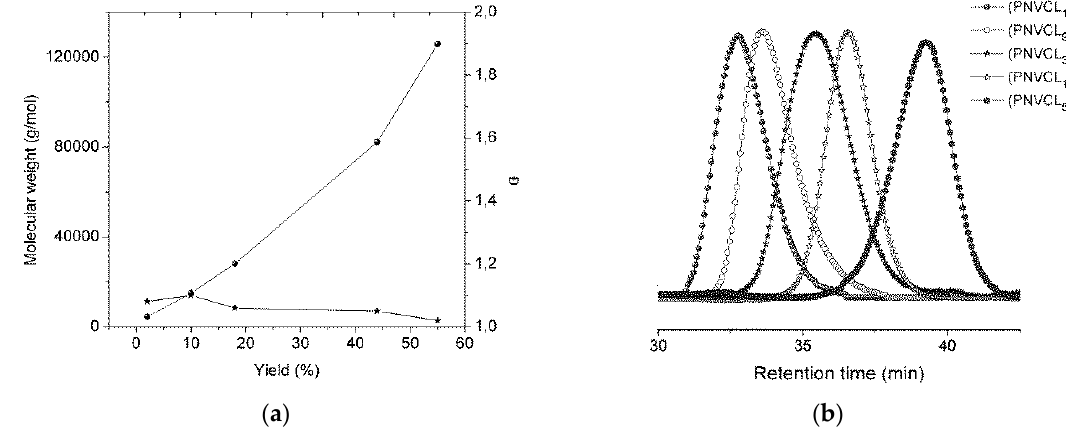
Figure 1. ( a ) Evolution of the molecular weight with conversion for the reversible addition–fragmentation chain transfer (RAFT) solution polymerization of PNVCL (poly( N -vinylcaprolactam) at 30 °C in the presence of the hexafunctional CTA-1. [NVCL] o = 14.4 mol/L, [NVCL] o :[CTA] o ratio = 2320. ( b ) Normalized GPC (gel permeation chromatography) traces of star PNVCL polymers in THF (tetrahydrofuran).